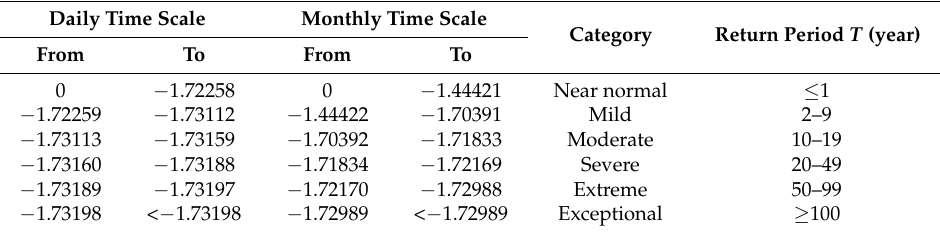
Table 3. Categorization of drought